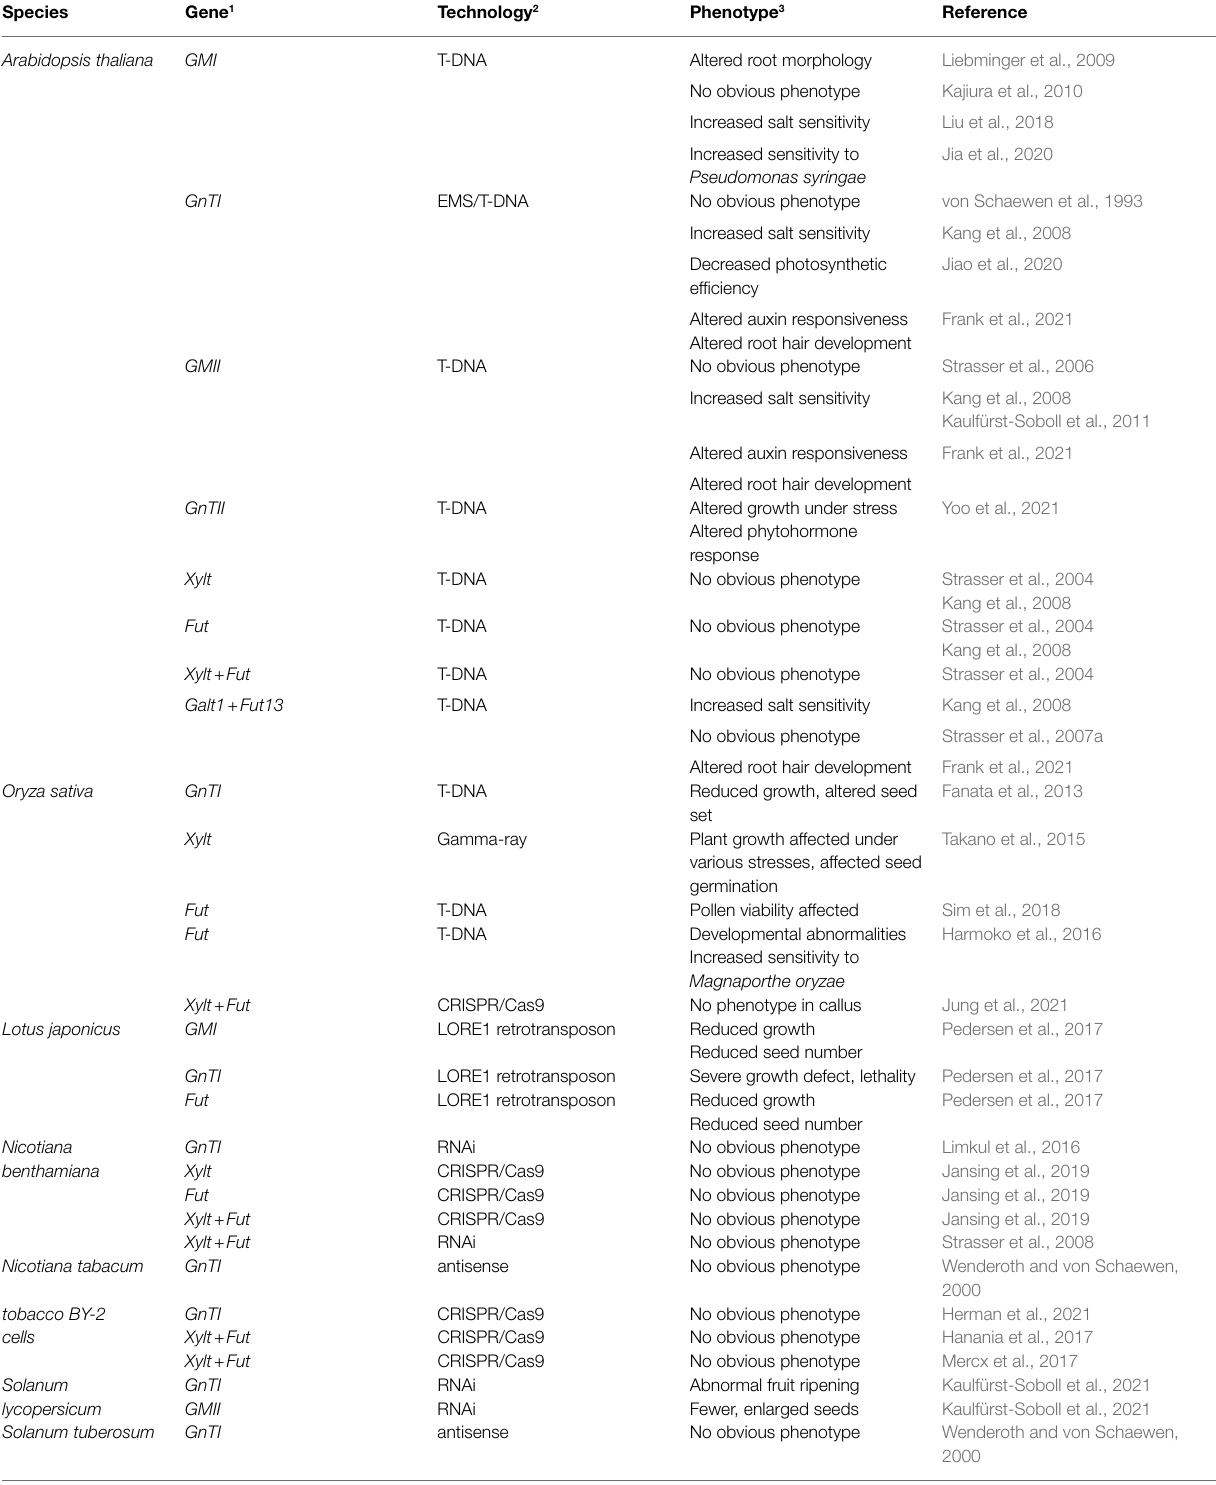
TABLE 1 | Overview of phenotypes in vascular plants with aberrant N